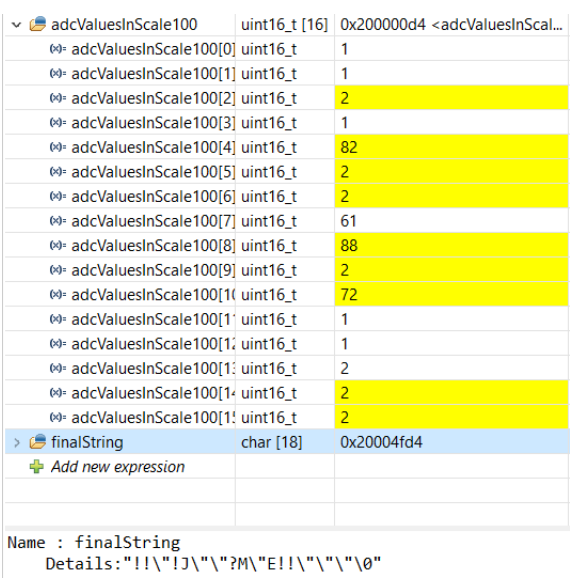
Figure 17. Screenshot of data conversion to char